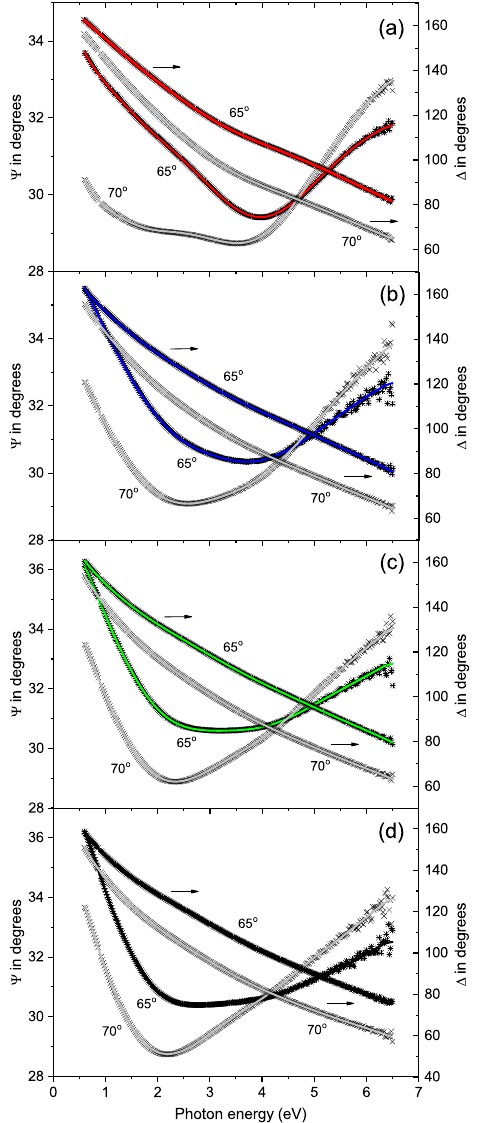
Figure 2. ( a – d ) Ellipsometric angles, Ψ ( ω ) and ∆ ( ω ) (symbols), measured at the angles of incidence of 65 ◦ and 70 ◦ for the Al 2 O 3 /[Bi( d )–NiFe(1.8nm)] 16 /Sitall multilayered films where the Bi spacer layer thicknesses d =0.6, 1.4, 2.0, and 2.5nm, respectively. The solid red, blue, green, and black curves show the corresponding simulation results for a 65 ◦ angle by the dielectric function model using Equation